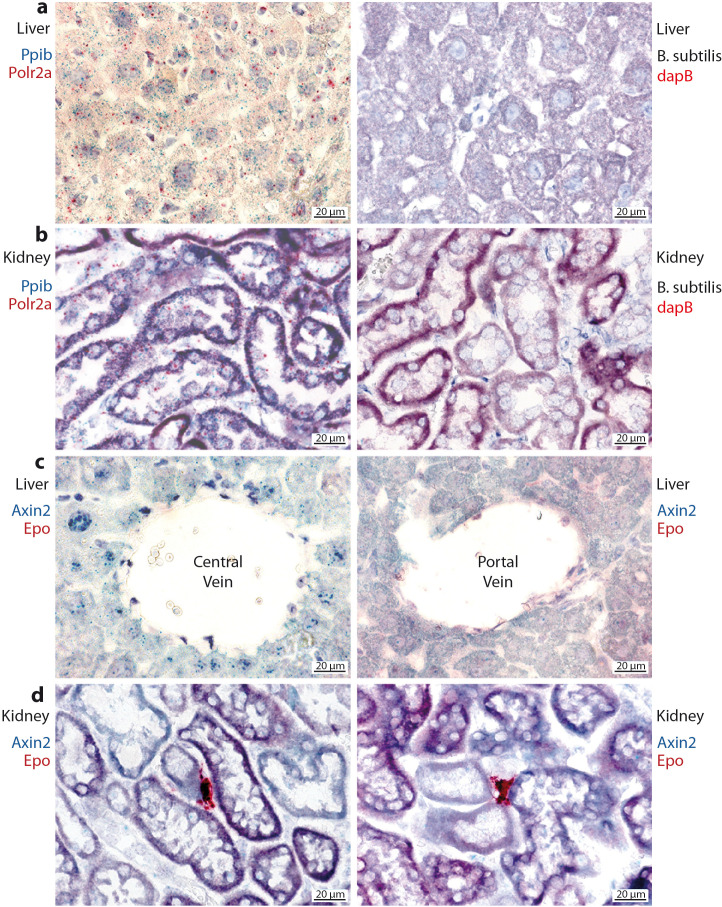
Implementation of in situ Hybridization for Axin2 and Epo mRNAs using RNAScope, showing expressing mRNA as dots.(a,b) Ppib (blue) and Polr2a (red) were successfully found expressed in liver and kidney FFPE sections of control mice. No expression of bacterial dapB was found. (c) In control livers, Axin2 mRNAs (blue) were restricted to the hepatocytes surrounding the central vein as a consequence of Wnt signaling in that area. No Epo was expressed. (d) In control kidneys, Epo mRNAs (red) were abundantly detected in rare interstitial cells.